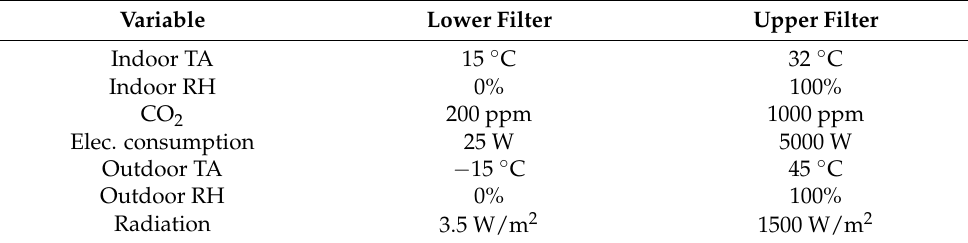
Table 1. Filters applied to the dataset values.